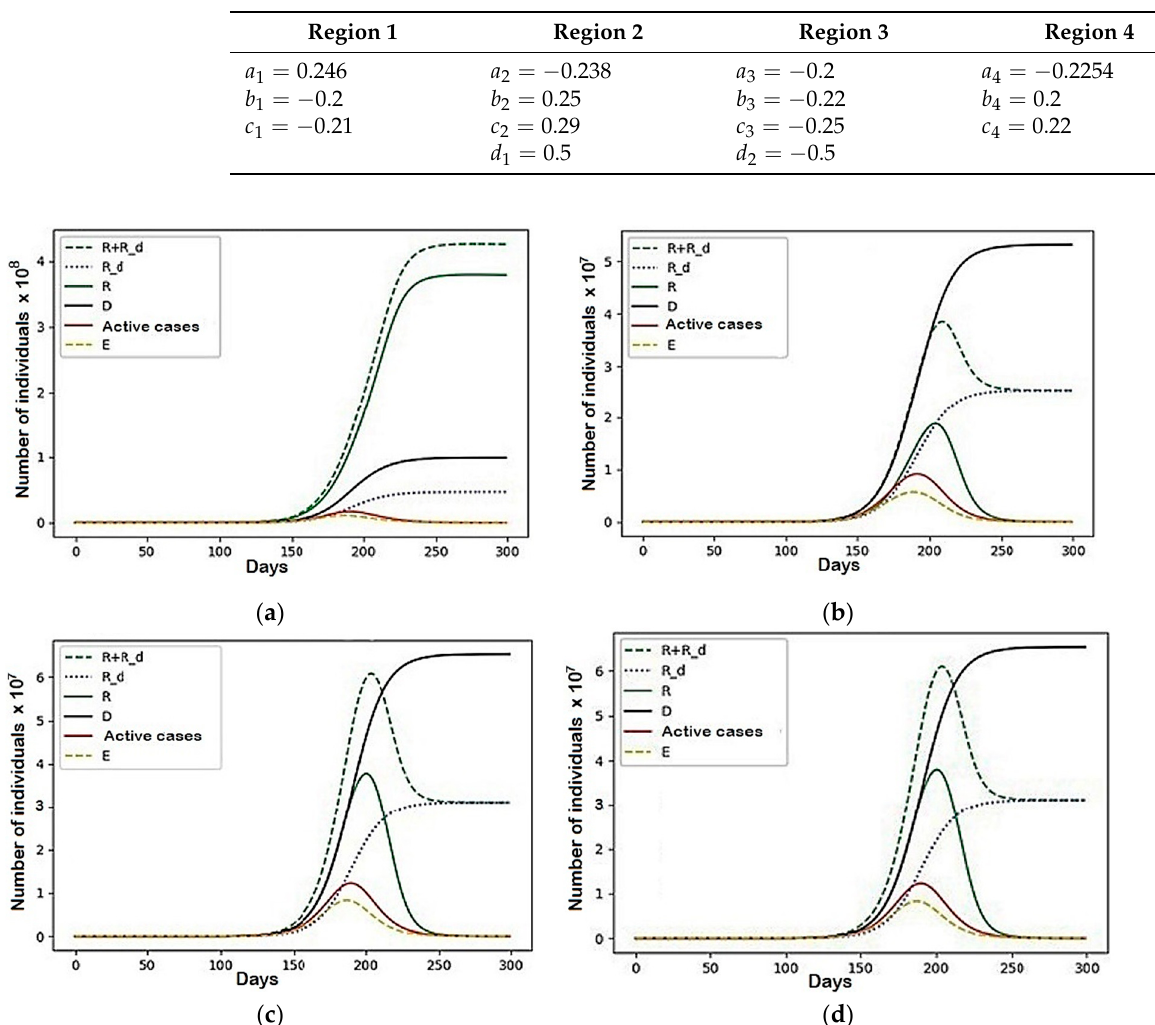
Figure 12. The case with the parameters represented in Table 1: ( a ) Region 1; ( b ) Region 2; ( c ) Region 3; ( d ) Region 4. ( d ) Region